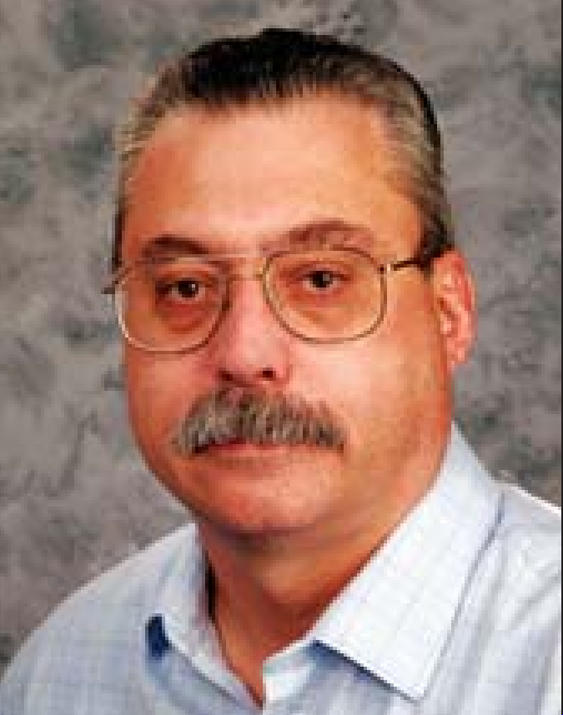
Michael R. Waalkes